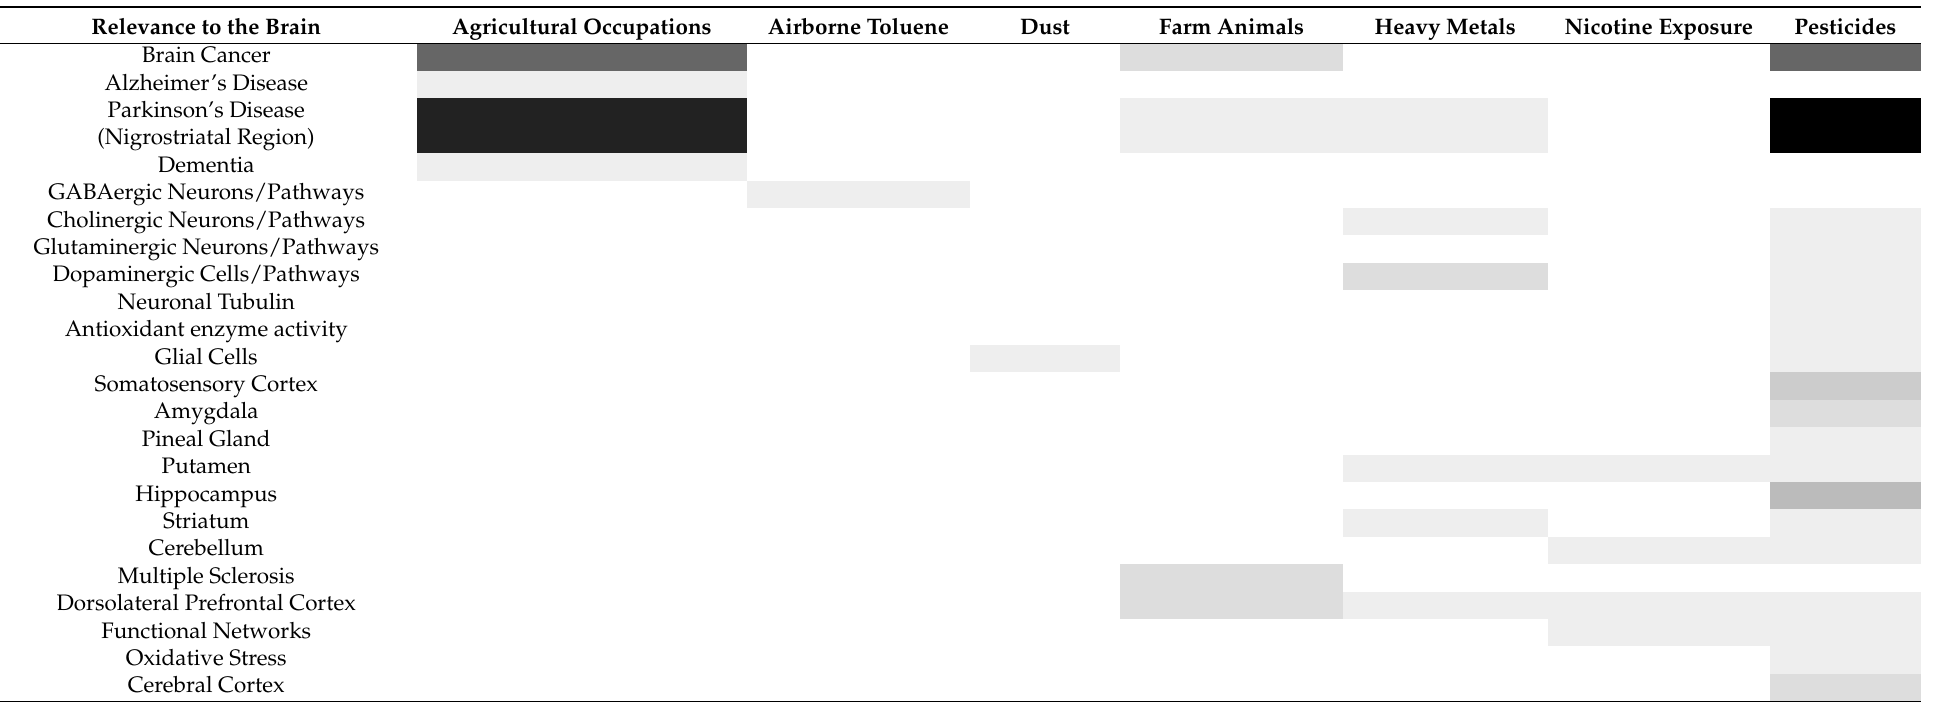
Table 2. A representation of the risk factors and relevance to the brain with darker gray representing more articles (darkest gray = 23 articles), lighter gray representing fewer articles, and white representing no